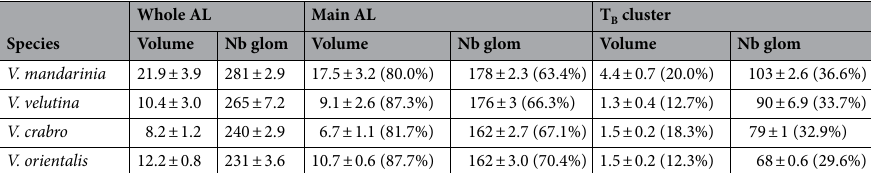
Table 1. AL volume and glomeruli numbers in four hornet species. The table shows AL volumes (calculated as the sum of the volumes of all glomeruli; × 10 6 µm 3 ) and the numbers of glomeruli (Nb, ± standard deviation) in all studied species. Values are also given separately for two AL compartments (T B cluster and the main AL), along with the respective proportion of the whole AL, shown within brackets.